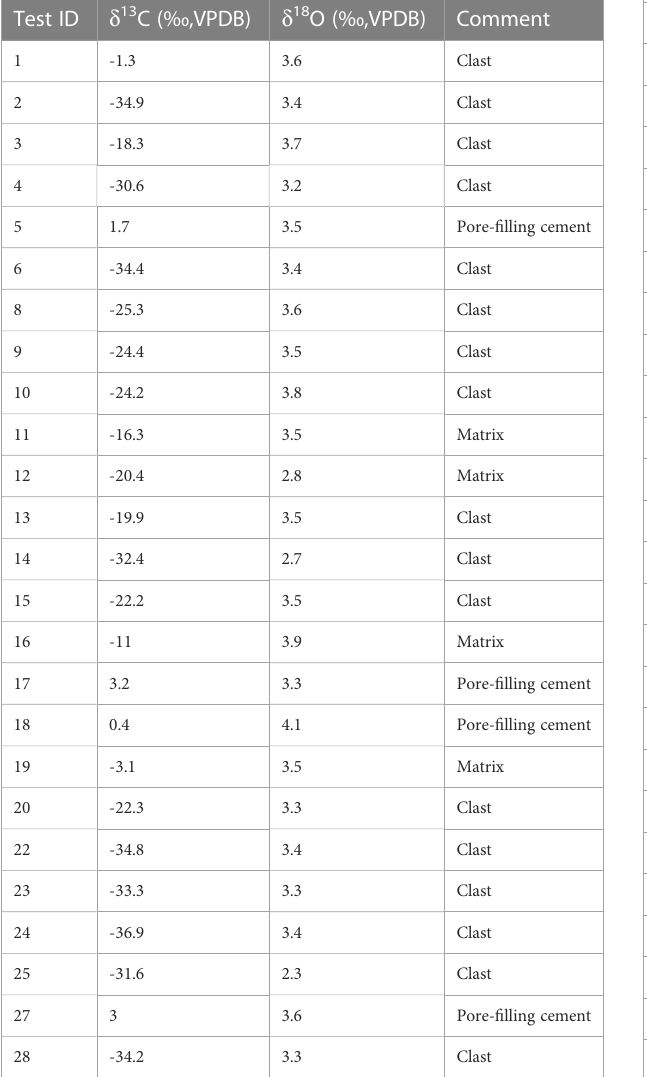
TABLE 2 Stable carbon and oxygen isotopic compositions of the seep carbonate.